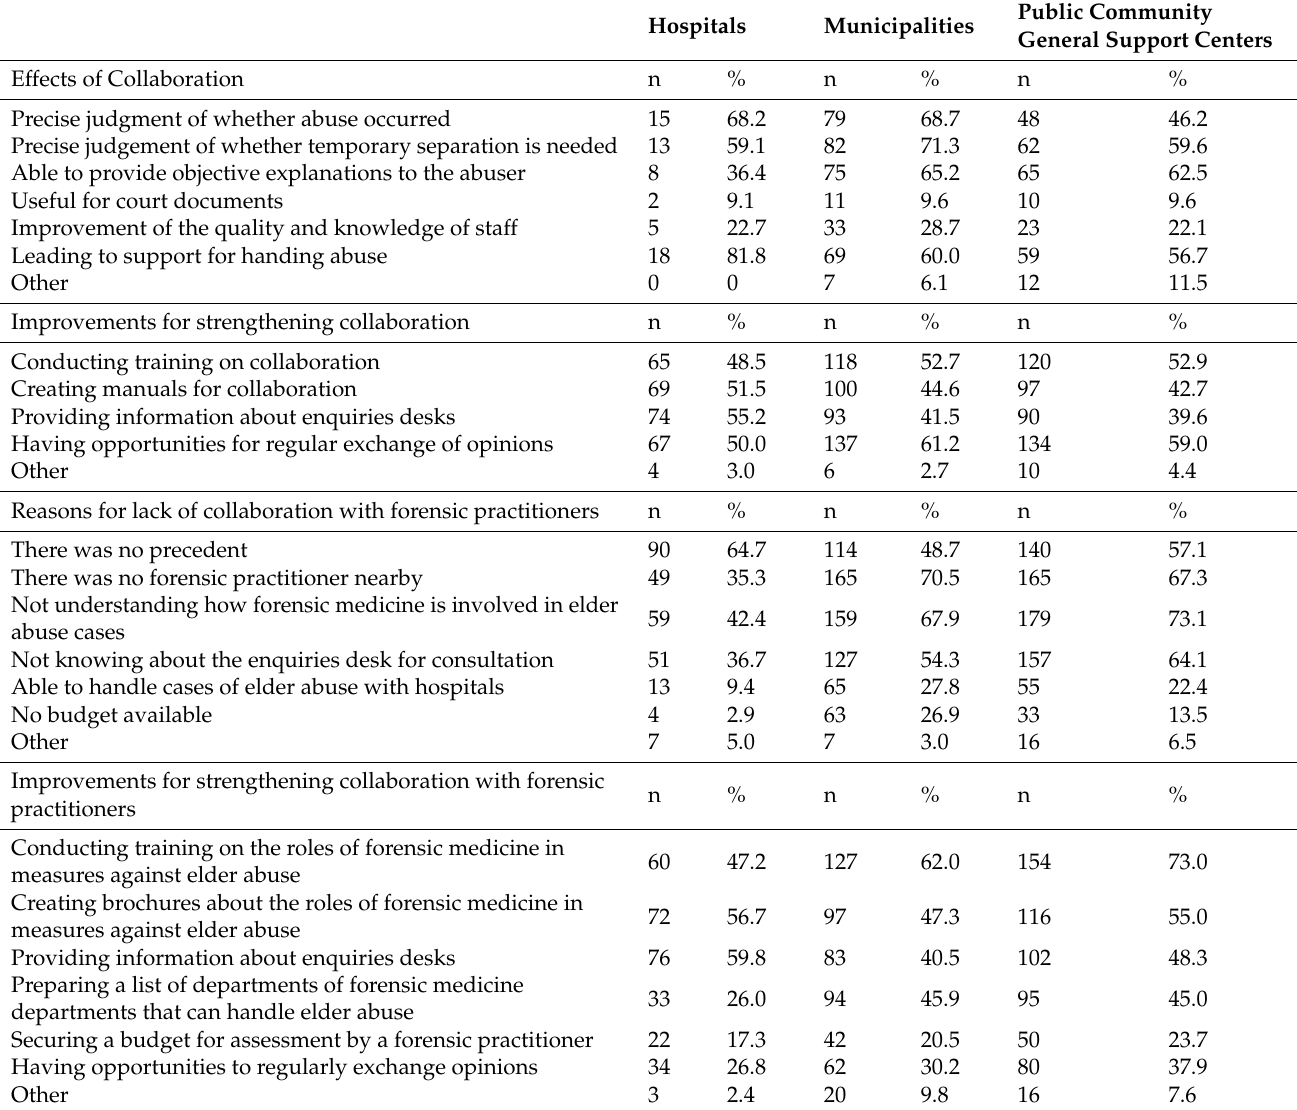
Table 4. Responses on collaboration between hospitals, municipalities and public community general support